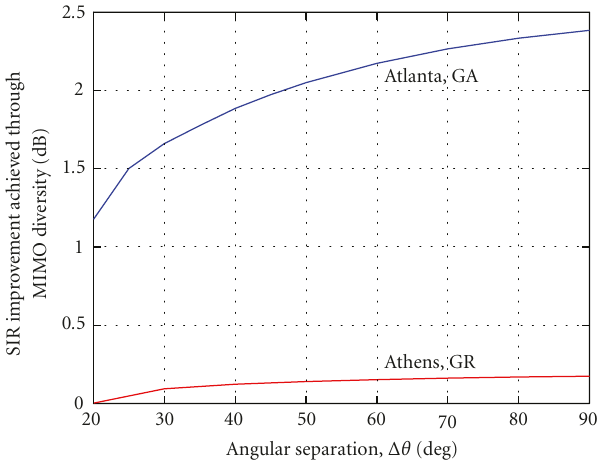
Figure 8: SIR improvement achieved by a satellite 2 × 2 MIMO di- versity system with receive antenna selection over the relevant SISO system versus angular separation Δ θ . E ff ect of rain climatic condi- tions over the serviced area.